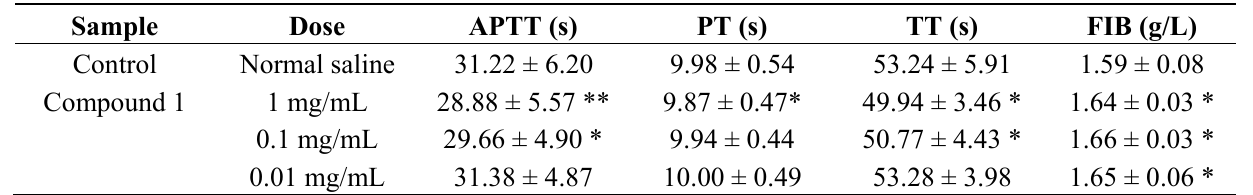
Table 2. Coagulant activity of compound 1 a